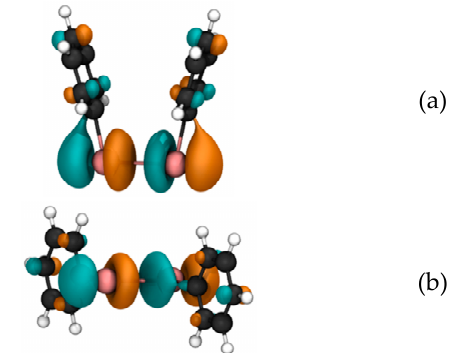
Figure 8. HOMO (left) and LUMO (right) of Ph 2 Te 2 with Ψ = 0 ◦ ( a ) and with Ψ = 180 ◦ ( b ). Isodensity 0.05 a.u. Level of theory: